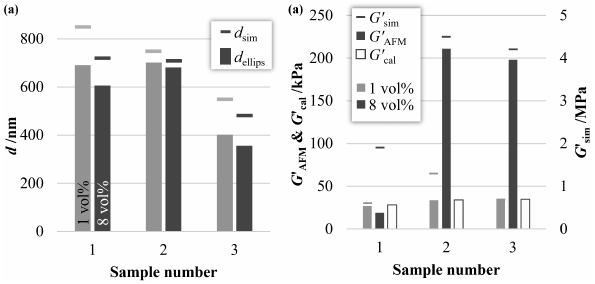
Figure 4. Comparison of directly (measured) and indirectly (sim- ulated, calculated) determined film parameters in 1 and 8 vol% cleaner concentration: (a) thickness; (b) storage modulus.